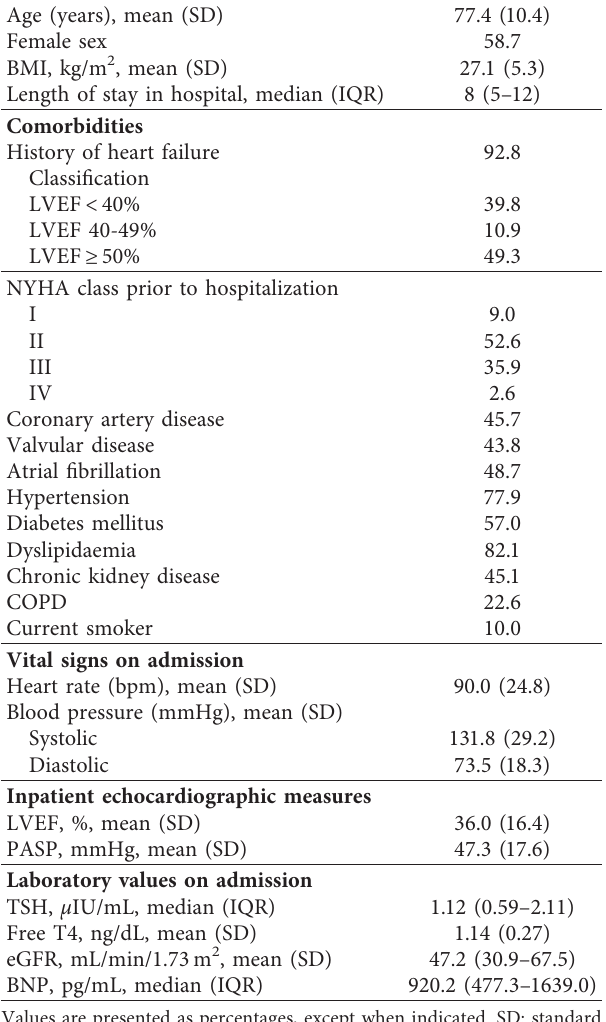
Table 1: Clinical characteristics of the patients ( n �